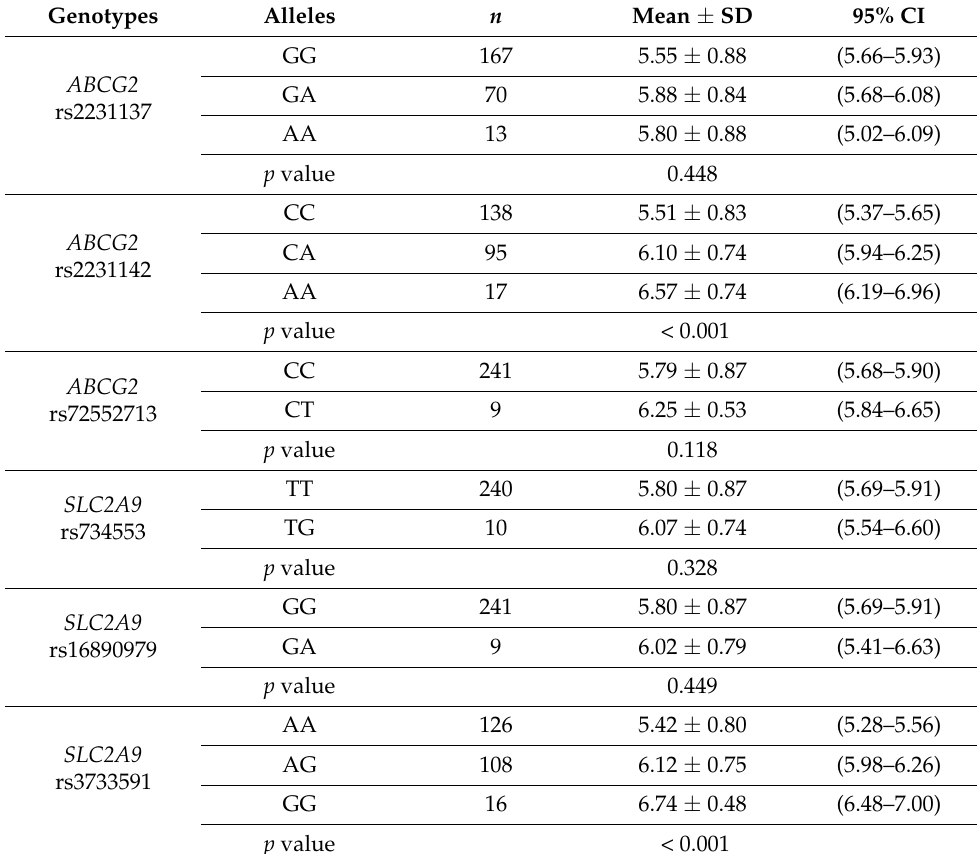
Table 3. Comparisons between serum uric acid levels according to the ABCG2 and SLC2A9 polymor-